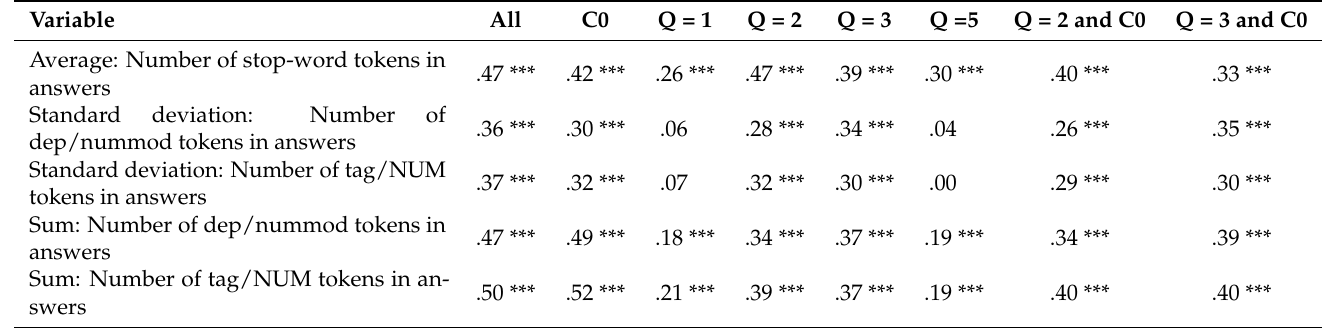
Table 2. Some interesting regressors using linguistic features of the answer. Correlation corresponds to the Pearson coefficient between the regressor and SIMCE score. The notation C0s correspond to filter by coherent responses. The notation Q corresponds to filter by responses to Q-type